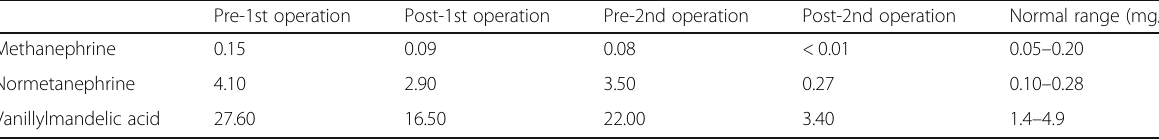
Table 1 Results of catecholamine metabolite ratios in 24-h urine collection